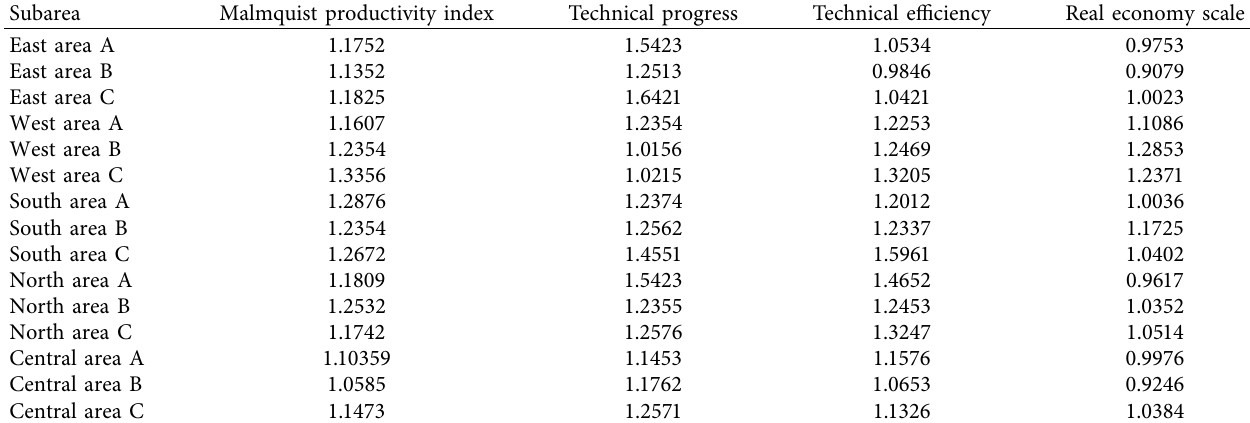
Table 6: Mean of the Malmquist productivity index and mean of its components. Subarea